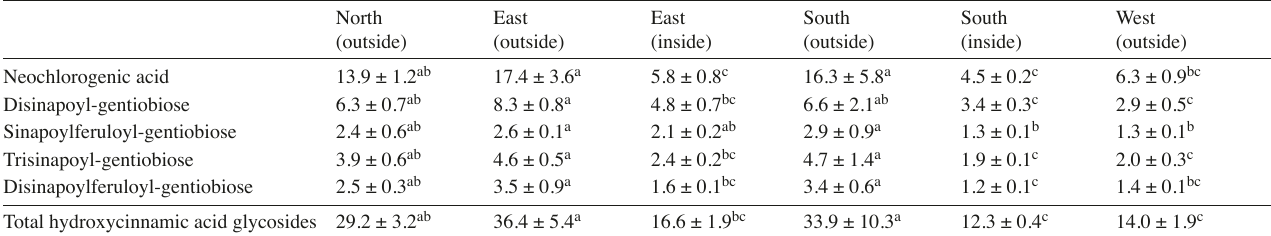
Tab. 3: Concentrations of hydroxycinnamic acids [mg * 100 g -1 FW] in kale samples harvested after 7 weeks of growth under urban gardening conditions in northern, eastern, western, and southern locations, including 2 indoor locations (east and south). Different letters indicate significant differences of means according to Tukey’s test ( p ≤ 0.05).